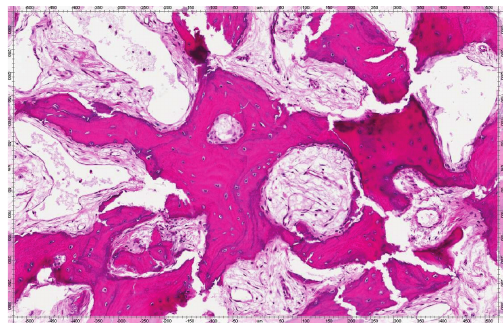
Figure 4: Medium power (100X, H&E stain) photomicrograph demonstrates thickened bone trabeculae exhibiting prominent reversal lines and increased vascularity within the intertrabecular